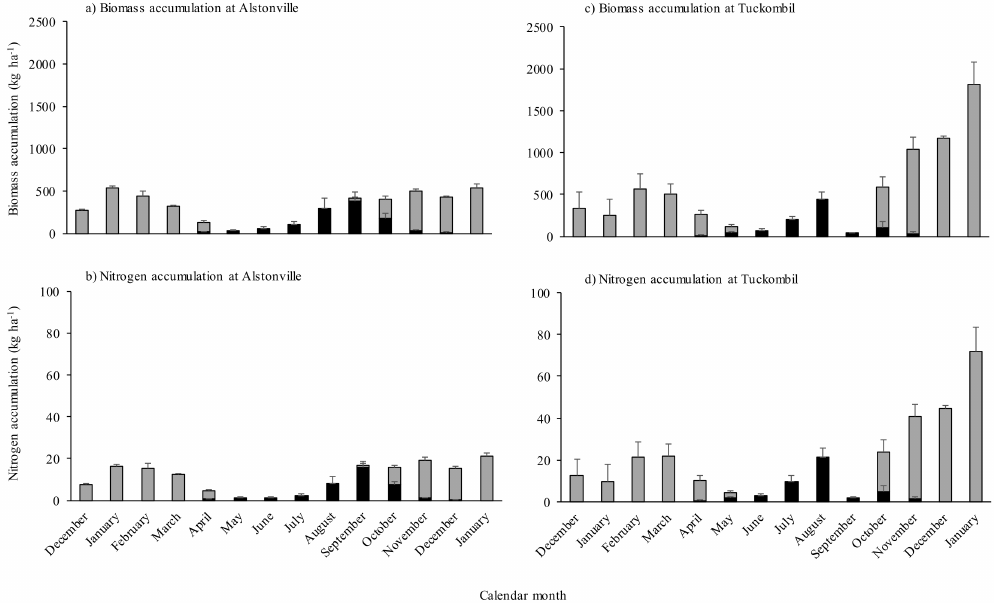
Figure 1. Pinto peanut and white clover biomass production at Alstonville ( a ) and Tuckombil ( b ), and nitrogen accumulation to Alstonville ( c ) and Tuckombil ( d ) in the 2015 calendar year. Grey shading indicates Pinto peanut and black shading indicates white clover. Error bars are SEM ( n =